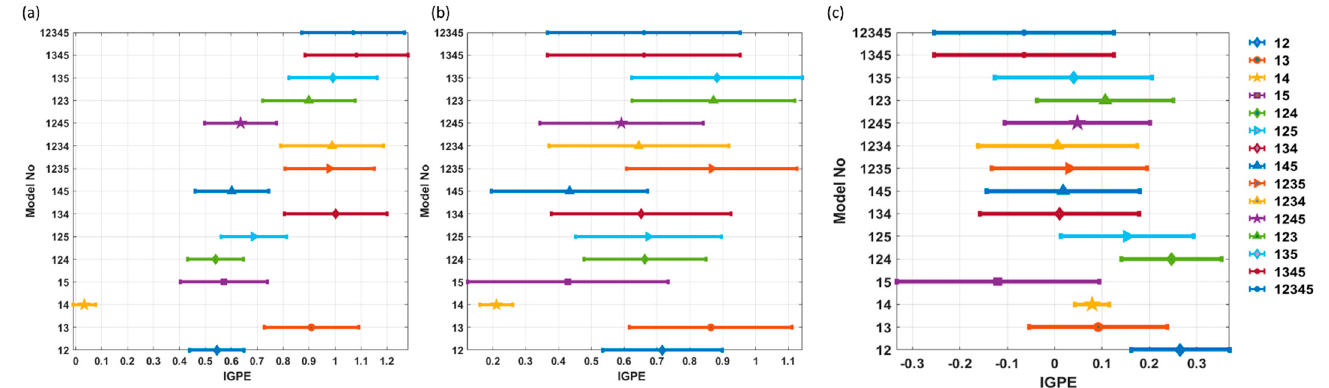
Figure 4. Information gain per earthquake (IGPE) of hybrid models relative to SUP baseline model with the GSS strain rate covariate. The combination of covariates contributing to each hybrid is indicated by the model number, which is a composite of the numbers corresponding to the baseline model and selected covariates, as follows: 1-SUP; 2-PPI; 3-PMF; 4-FLT; 5-GSS. ( a ) Fitting period (1987–2006); ( b ) Forward testing period (2012–2015); ( c ) Reverse testing period (1951–1986). Error bars are 95% confidence intervals.